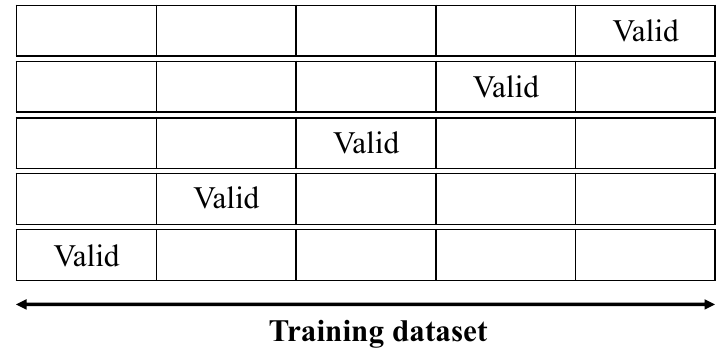
Figure 5. Five sets of valid data in the training dataset.